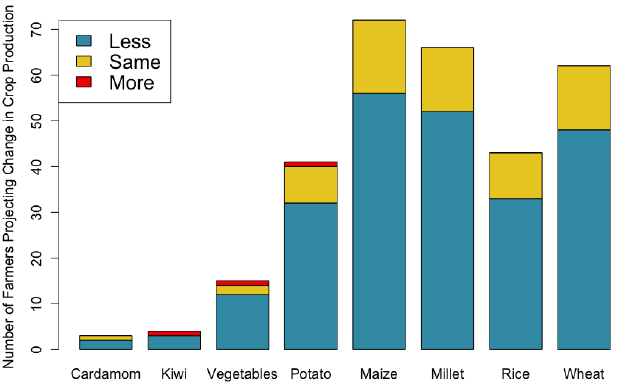
Fig. 4 . Bar chart of changes in crop planting for the 2016 harvest year based on farmer responses. Respondents were questioned on their 2016 planting regimes compared with before the earthquakes. The X-axis shows common crops and the Y-axis shows the number of farmers who planted “less,” “the same,” or “more” of each crop for the 2016 planting cycle (n =